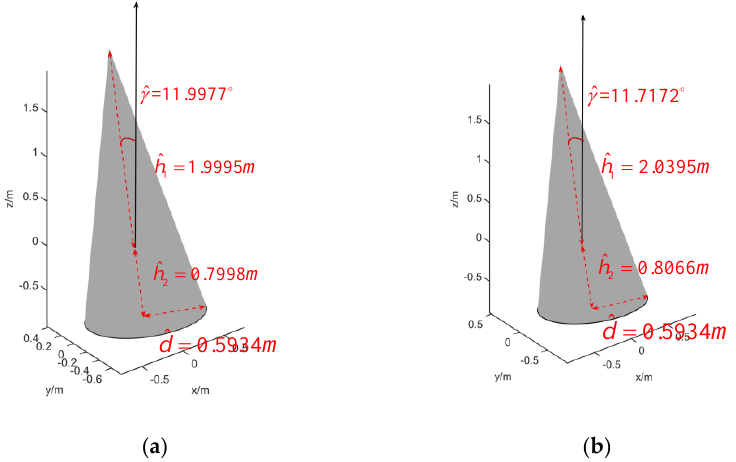
Figure 9. Three-dimensional reconstructed image. ( a ) Estimated target geometric parameters under case 1. ( b ) Estimated target geometric parameters under case 2.